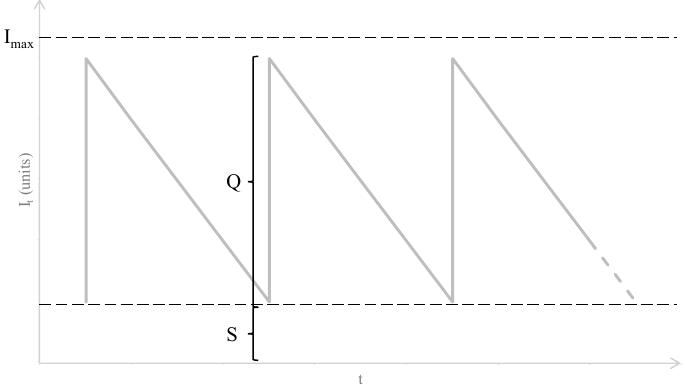
Figure 1. Inventory level over time.